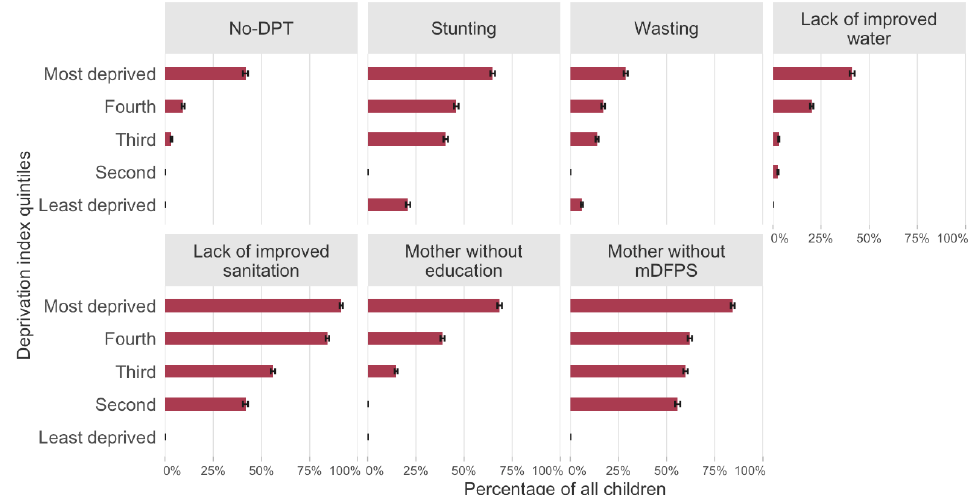
Figure 5. Prevalence of each indicator according to deprivation index quintiles (all 80 countries).